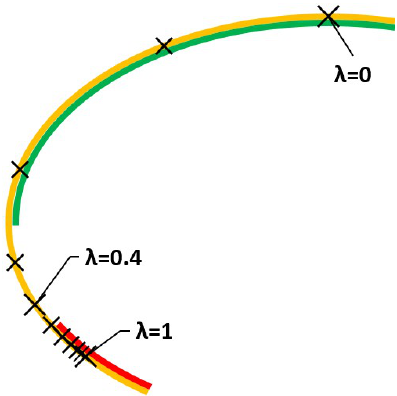
Figure 4. Solutions using compromise programming for p =